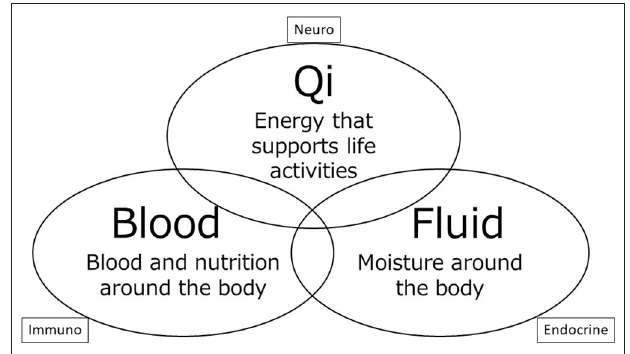
FIGURE 1 | Theory of Qi, Blood, Fluid. The three elements showing in this figure are thought to maintain the living body within the Kampo medicine framework. Three elements go around the mind and body, and make them work. Symptoms are caused by impaired circulation and quantity of three